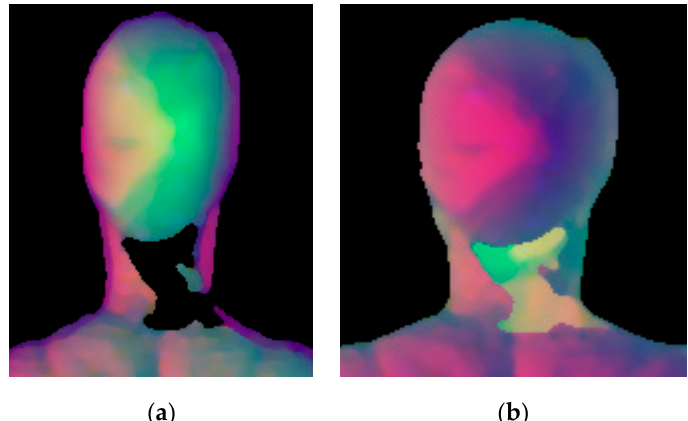
Figure 18. Comparison of images generated via mid-surface ( a ) and orthogonal projection ( b ) for back view.